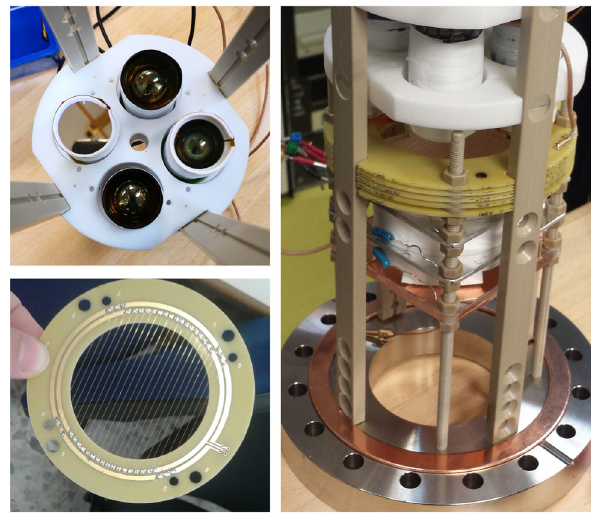
Fig. 1 Some key elements of the setup used in the present measure- ments. Left-top: pressure-resistant PMs (R7378 from Hamamatsu) with band-pass filter (positioned left-right in the frame) and without (top- bottom). Left-bottom: a cathode from one of the multi-wire propor- tional chambers (corresponding to the plane dubbed ‘readout’ in Fig. 2). Right: the setup once assembled and prior to mounting inside the